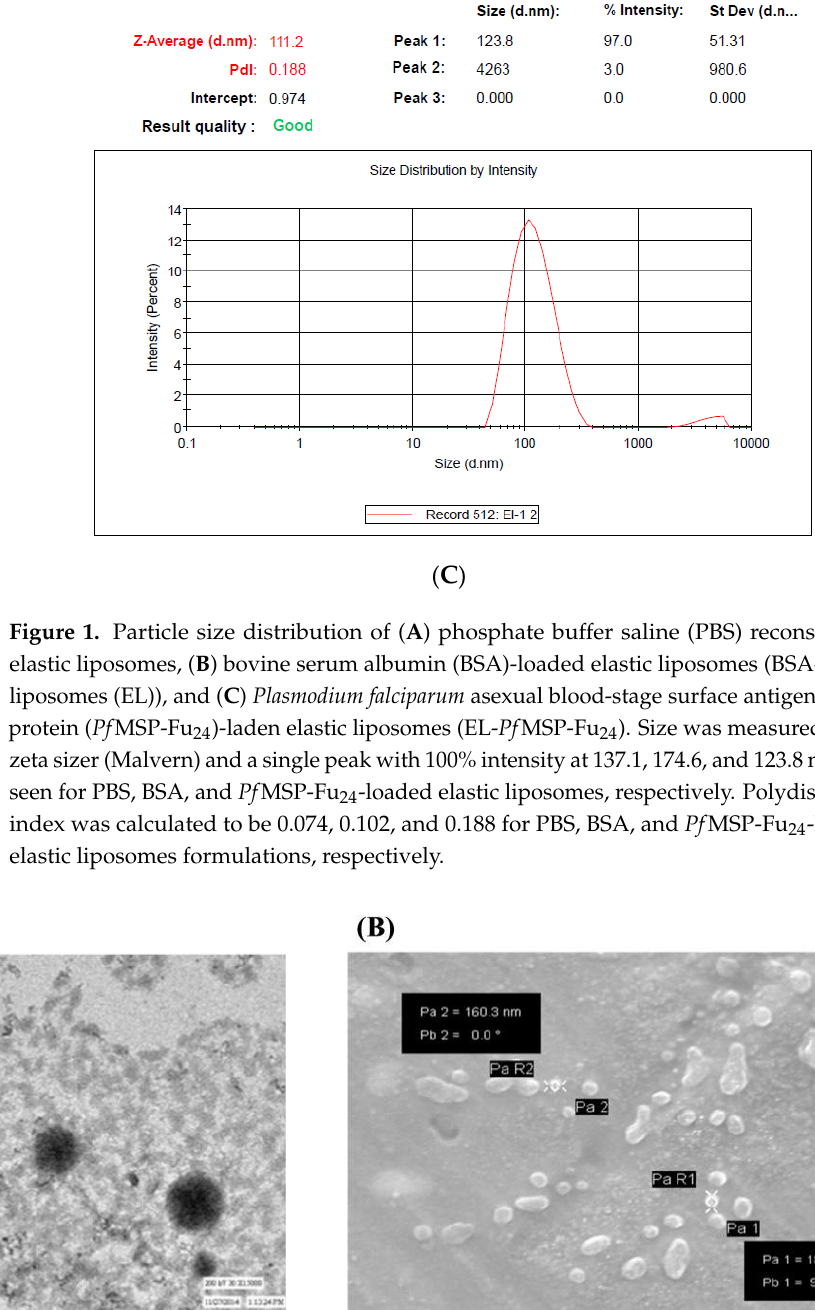
Figure 2. High-resolution, ( A ) TEM photomicrograph of EL- Pf MSP-Fu 24 formulation at 100× magnification, and ( B ) SEM analysis of model antigen (BSA)-loaded elastic liposomes (EL-BSA) showing surface morphology of prepared formulation.